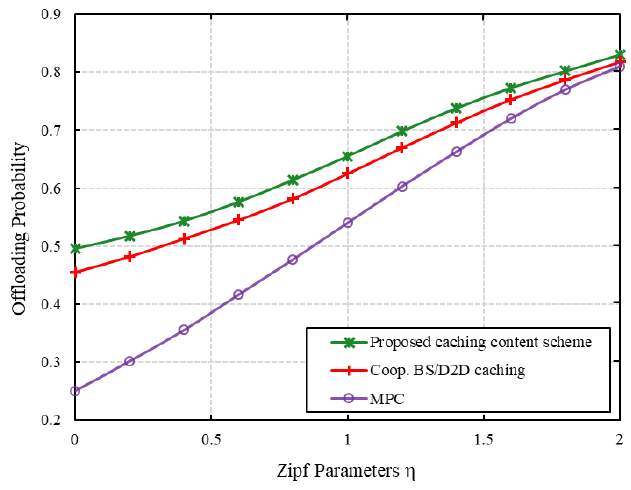
Figure 4. Performance comparison among three different caching schemes with varying Zipf parameter η .